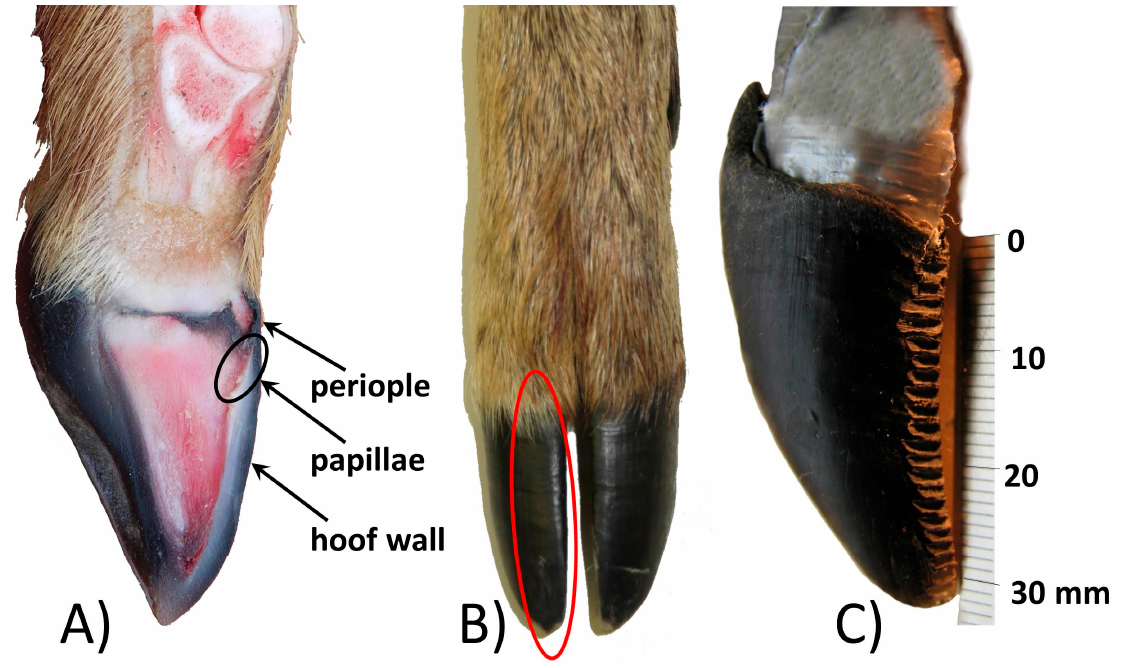
Figure 1. ( A ) Cross-section of a hoof; ( B ) Front view of a roe deer foot (oval denotes front edge of the hoof); ( C ) Side view of a hoof after sampling the front edge.